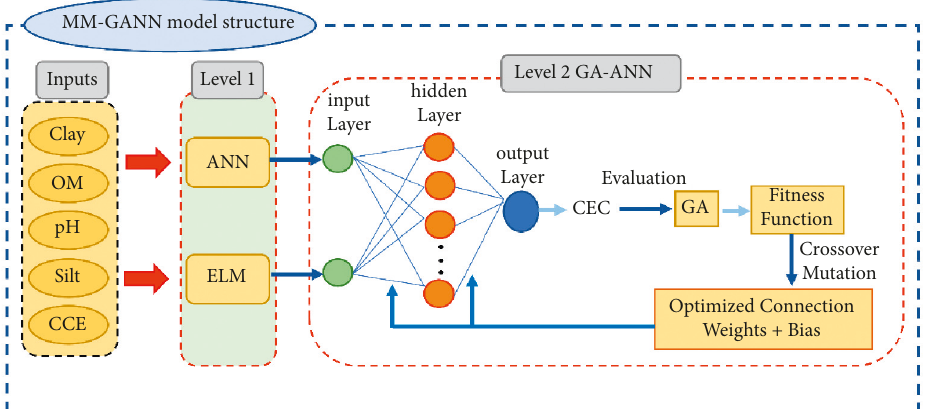
Figure 4: Structure of MM-GANN